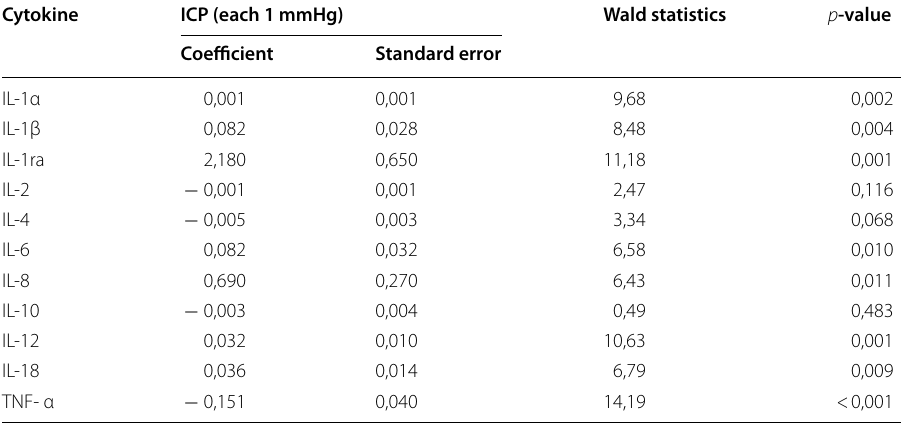
ICP intracranial pressure. One degree of freedom for each model